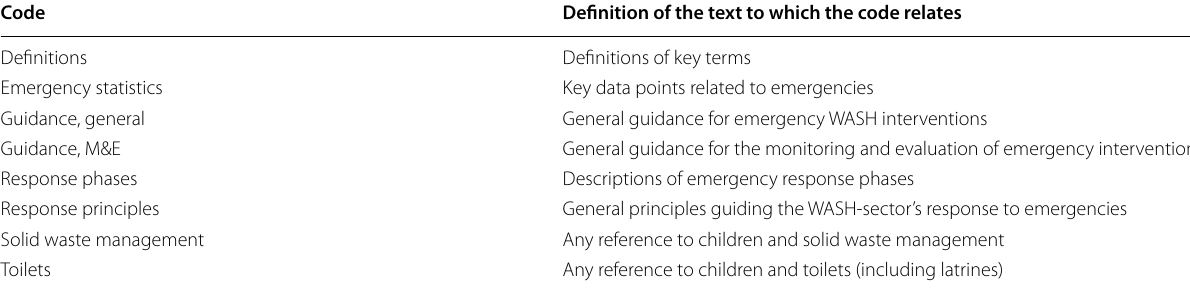
Table 1 Codebook for Criterion 2a publications